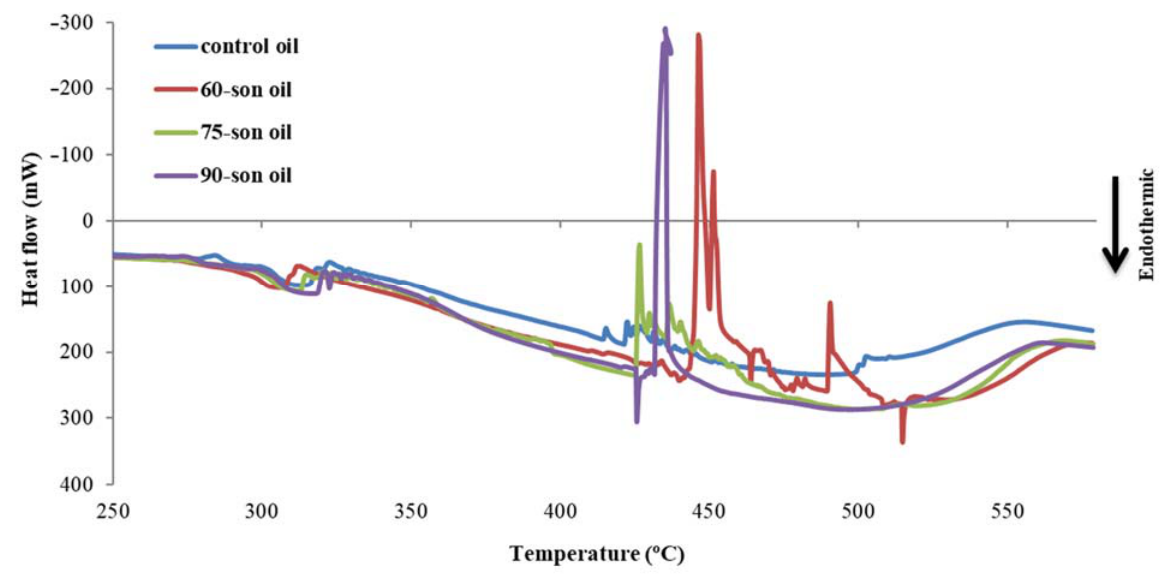
Figure 5. DSC diagram of enrichment sample oils; Curve of heat flow versus temperature.